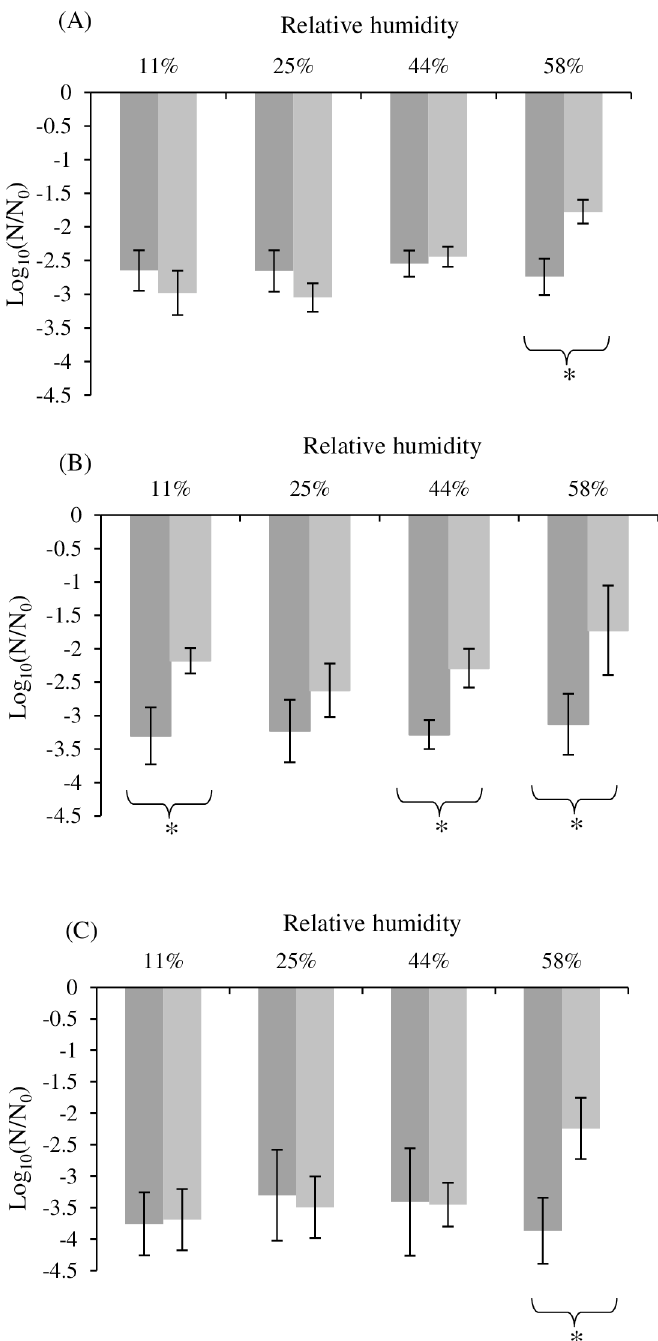
Fig 2. Impact of rehydration after drying on cultivability for C . sakazakii (A), S. Typhimurium (B) and S . Senftenberg (C). Dark grey represents the loss of cultivability obtained with instantaneous rehydration and light grey represents the loss of cultivability with rapid rehydration. Error bars represent SD calculated from triplicates and asterisks represent a significant difference between both conditions ( t -test, p < 0.05). The corresponding dataset was presented in S1